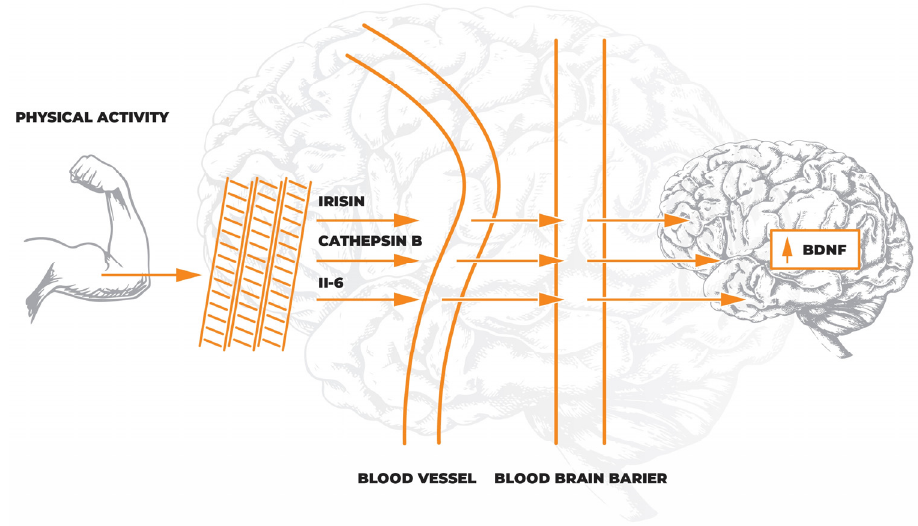
Figure 2. Diagram of the muscle–brain endocrine loop illustrating the process of induction of plastic changes in the brain in response to physical training. Physical activity leads to the release of myokines such as interleukin-6 (Il-6), irisin, and cathepsin B into the blood by striated muscles. By penetrating the blood–brain barrier, myokines induce an increased production of brain-derived neurotrophic factor (BDNF), mainly in the hippocampus. The presented process leads to improved neurogenesis and induction of neuroplasticity.